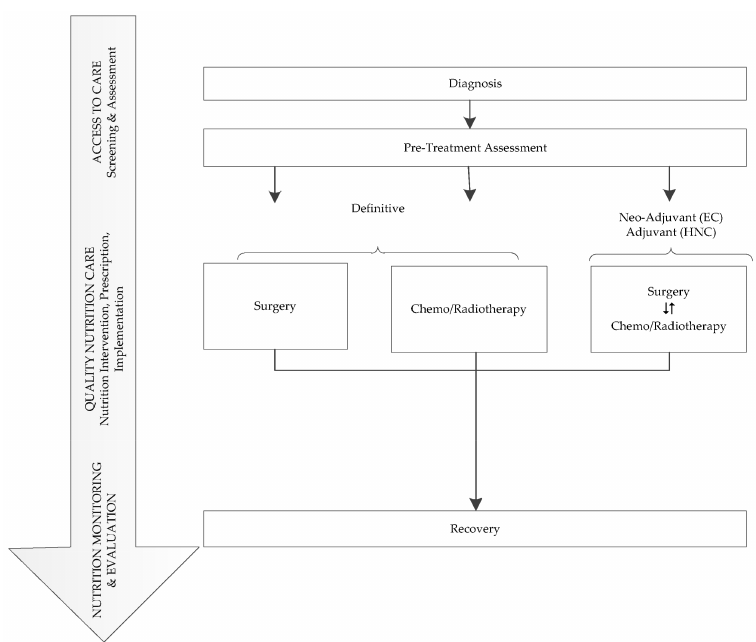
Figure 1. Overview of oncological treatment for patients with foregut tumors aligned with the Nutrition Care Model